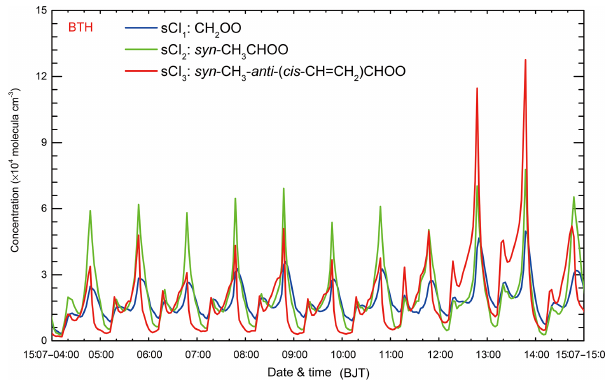
Figure 10. Temporal variations of the simulated concentration of different sCIs (blue line: sCI 1 ; green line: sCI 2 ; red line: sCI 3 ) in BTH from 4 to 15 July